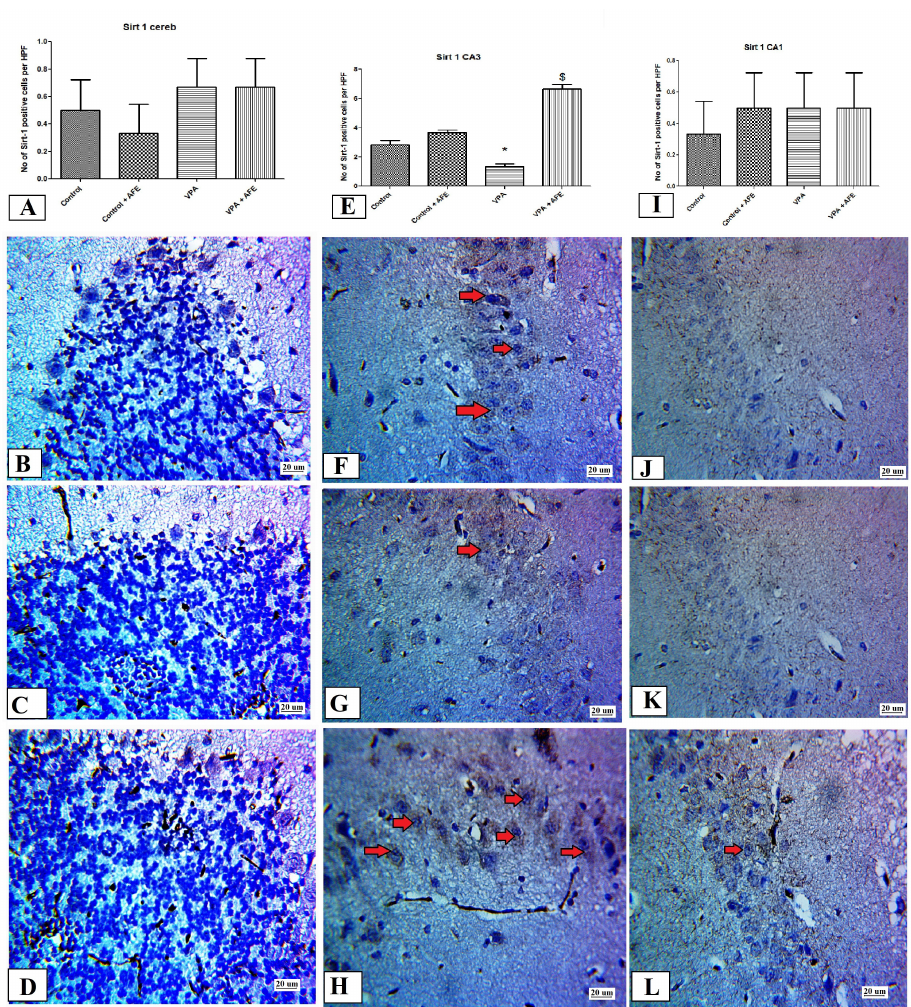
Figure 6. Effect of AFE on the Sirt-1 expression in the cerebellum and hippocampus. ( A , E , I ) show the mean number of sirt-1 positive cells in the Purkinje cells (PC) layer of the cerebellar cortex, CA3 hippocampal region, and CA1 hippocampal region of different groups, respectively. ( B – D ) show negative cytoplasmic expression of sirt-1 in the PC of the cerebellar cortex of the control, VPA, and VPA + AFE groups, respectively. ( F – H ) show positive cytoplasmic expression (red arrows) of sirt-1 in CA3 of the control (mild to moderate), VPA (minimal), and VPA + AFE groups (marked), respectively. ( J – L ) show negative cytoplasmic expression of Sirt-1 in CA1 of the control and VPA, and minimal cytoplasmic expression in the VPA + AFE group, respectively (400 × ). * significant vs. control group, and $ significant vs. VPA